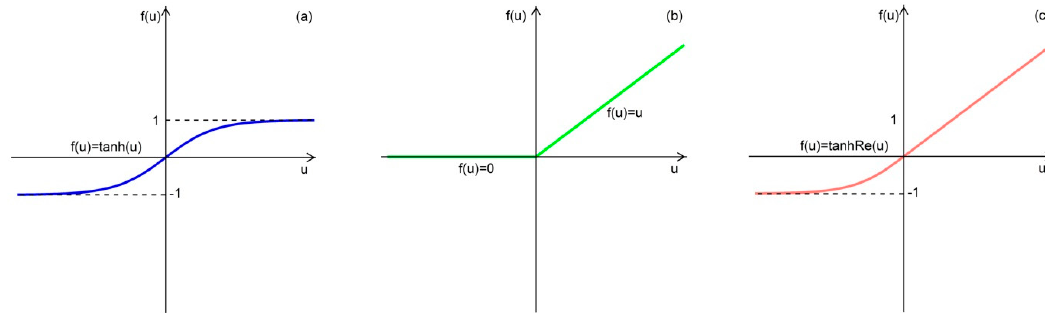
Figure 4. Shapes of the activation functions. Tanh ( a ), ReLU ( b ) and TanhRe ( c ).